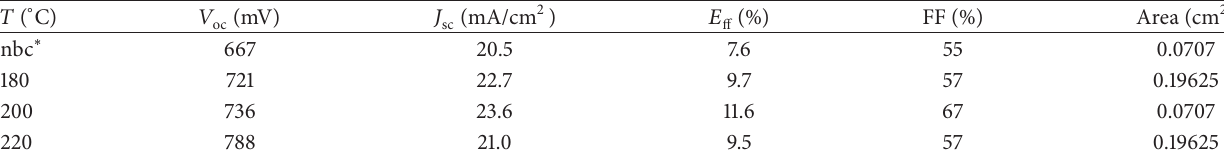
Te thin films. 1.4